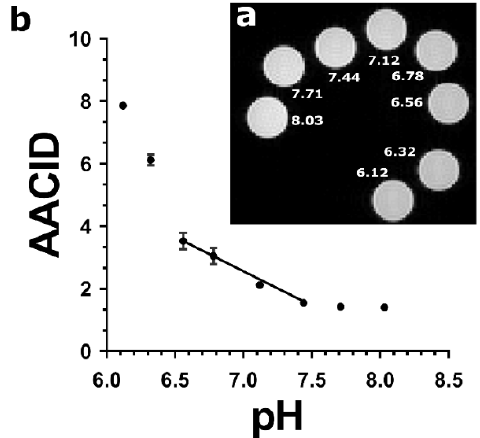
Figure 1. ( a ) T 2 -weighted FSE image showing cross sections of eight protamine samples at pH values ranging from 6.12 to 8.03 in NMR tubes scanned at 9.4T and at 37 °C. ( b ) AACID values calculated using the 2 ppm amine resonance as a function of pH in protamine samples. The relationship be- tween AACID and pH can be approximated as linear between pH 6.6–7.4. The AACID value is most sensitive to change at low pH (6.1–6.6) and does not change appreciably above pH 7.4. Error bars represent the standard error of the mean within each NMR tube.